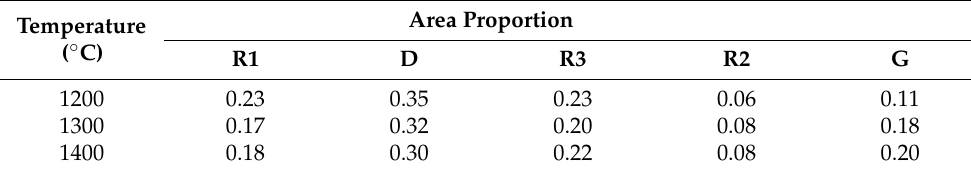
Table 3. Deconvoluted peaks area fraction as a function of pyrolysis temperature.